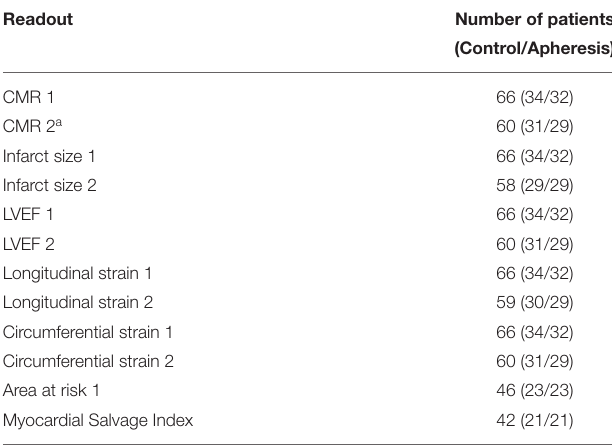
TABLE 3 | Overview of the number of patients for different CMR